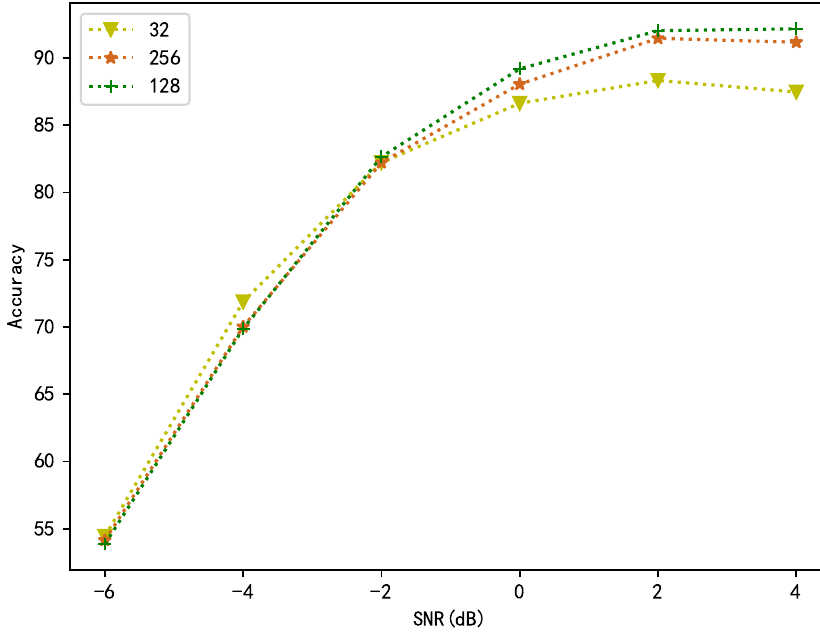
Figure 8. Recognition accuracy for different sequence lengths.